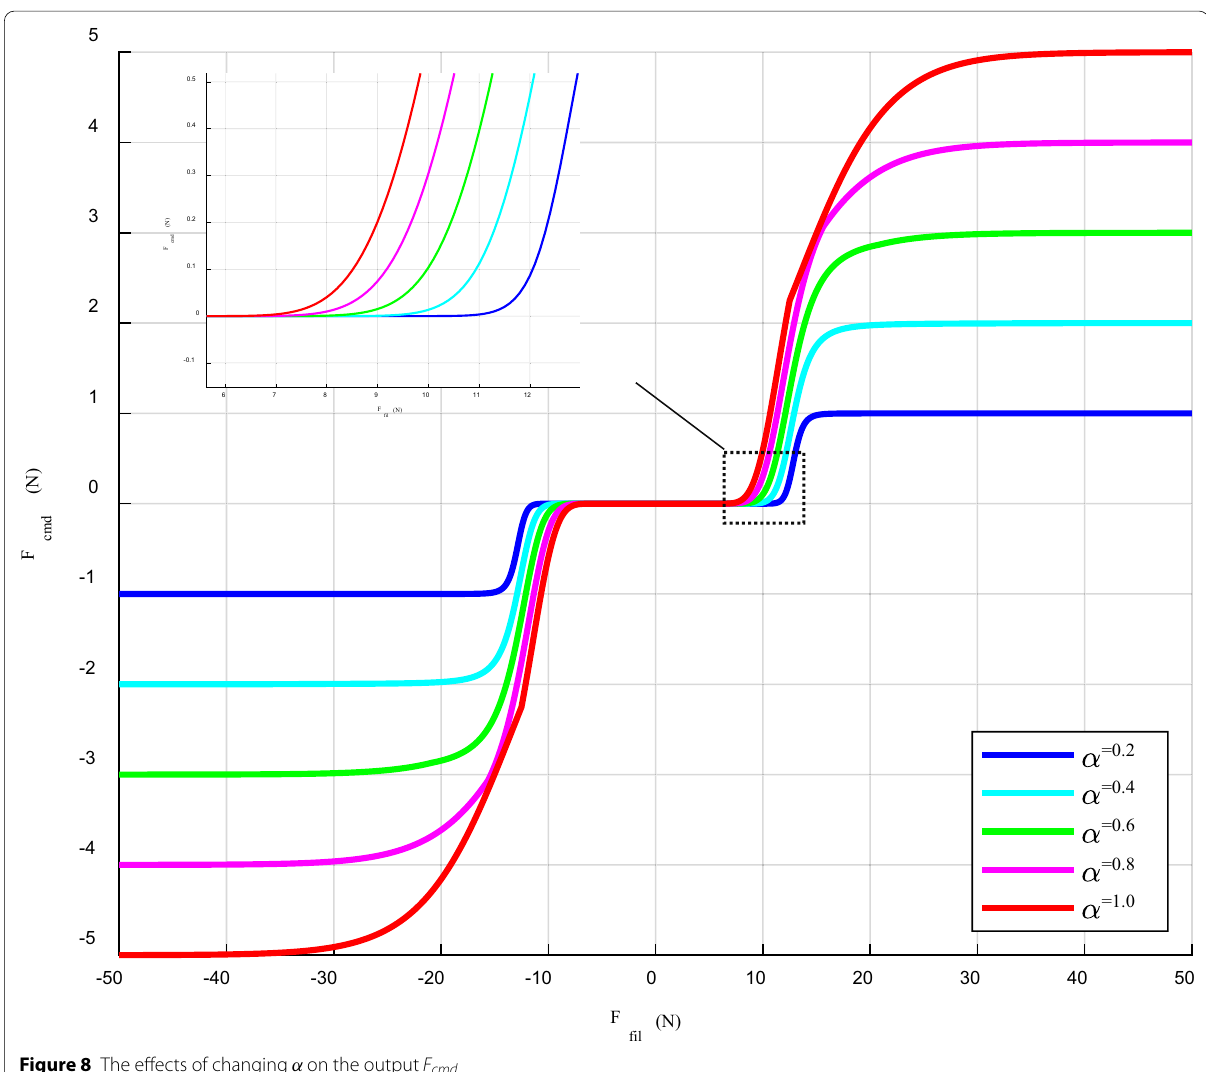
In the third experiment, the manipulator was teleop- erated to grasp a jug and pour water into a glass with online velocity adjustment. Figure 10 displays the detail of the third experiment with M = 30 , b = 4 , c = 0.8 , d = 0.4 , k = 8 and the diagonal of the damping matrix is [100, 100, 100, 20, 20, 20] . The limit force commands and positions of x - y - z are shown on the left y label in the top and bottom pictures, while the limit wrench commands and rotations of x - y - z are displayed on the right one. In the beginning, THCobot was teleoperated to move close to the jug with water by the applied forces from the oper- ator when α = 1 . Before the robot was close to the jug, α was re-set to 0.4 for decreasing the robot velocity.